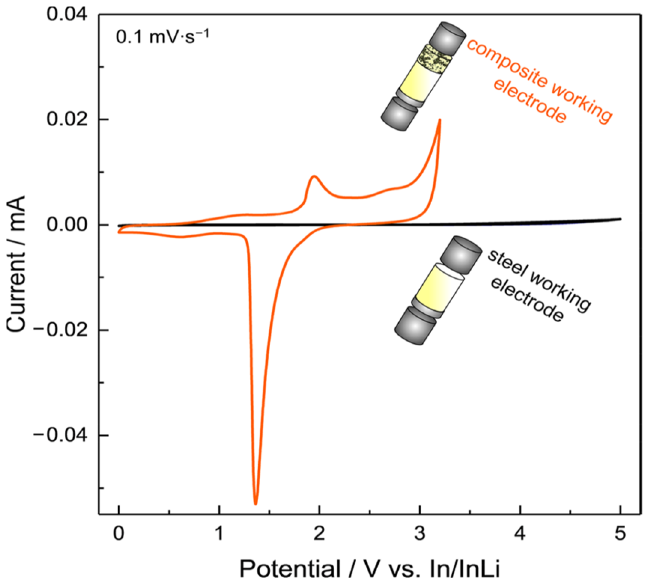
Figure 8. Visual comparison of two types of electrode morphology in CV experiments with the thiophosphate solid electrolyte Li 10 GeP 2 S 12 . Reprinted with permission from ref. [125]. Copyright 2019 American Chemical Society.